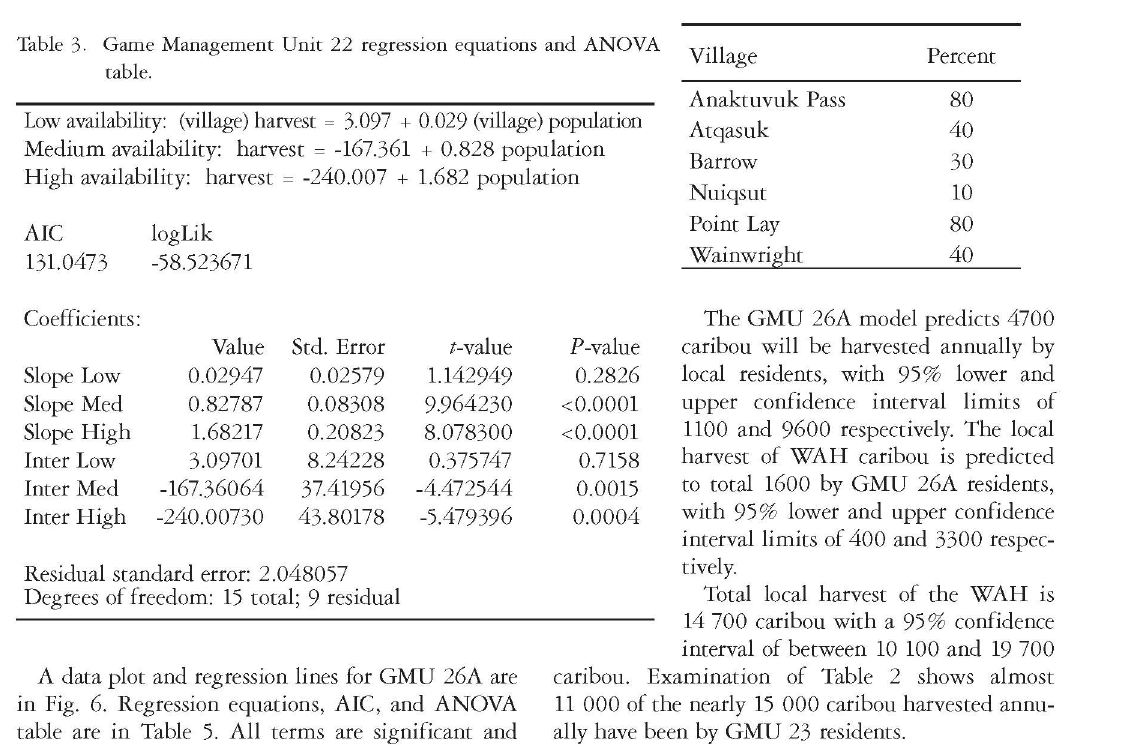
Table 3- Game Management Unit 22 regression equations and ANOVA table.